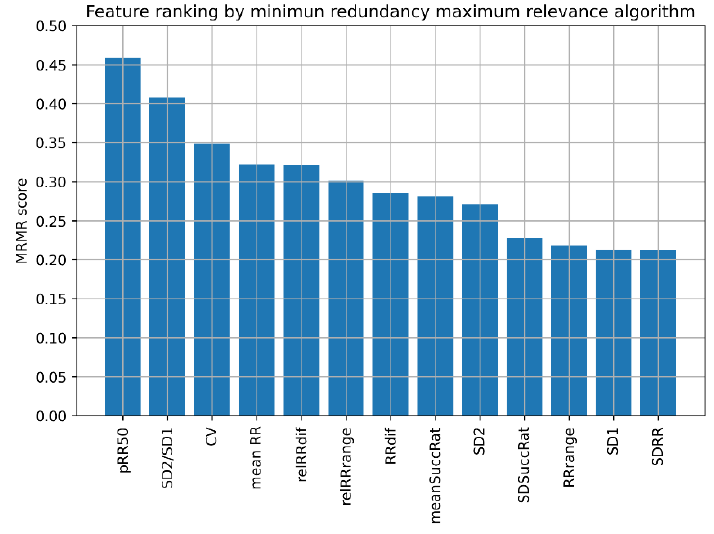
Figure 2. Ranking of heart rate variability features by minimum redundancy maximum relevance (MRMR) algorithm. pRR50 — percentage of successive differences between RR intervals greater or equal to 50 ms; SD1 and SD2 — standard deviation of points in the Poincare plot across and along the identity line, respectively; mean RR — mean of RR intervals; SDRR — standard deviation of RR intervals; RRdif — mean of absolute differences between successive RR; CV — coefficient of variance; relRRdif = RRdif/(mean RR); meanSuccRat — mean ratio of successive RR; SDSuccRat — standard deviation of ratios of successive RR; RRrange = max(RR) − min(RR); relRRrange = RRrange/(mean RR) (relative RRrange).